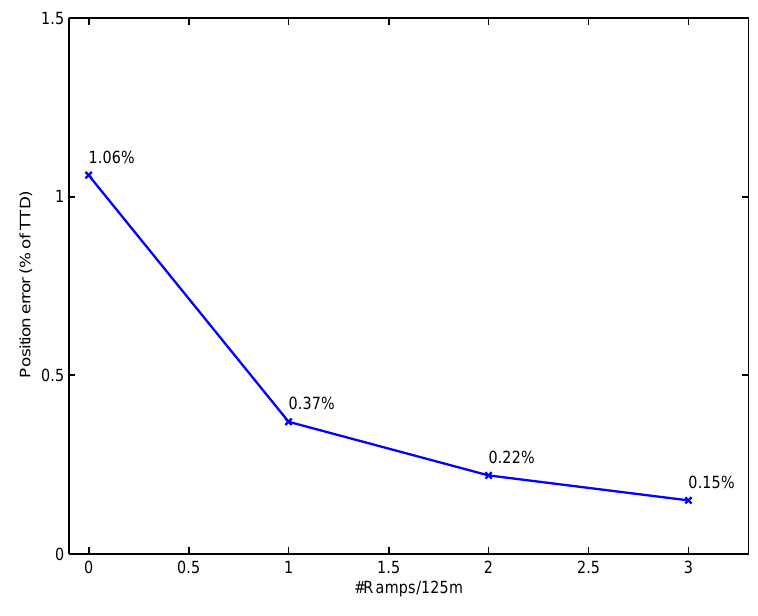
Figure 8. Influence of the Ramp density on the final position